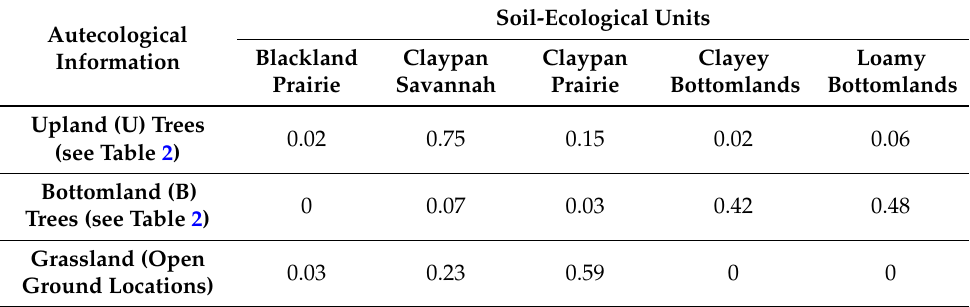
Table 5. The proportions of upland trees, bottomland trees and open ground locations in each soil-ecological unit. The proportions were determined by overlaying individual tree and open ground locations derived from surveyors’ records onto the soil-ecological units mapped in Brazos County by Natural Resources Conservation Service, US Dept. of Agriculture.